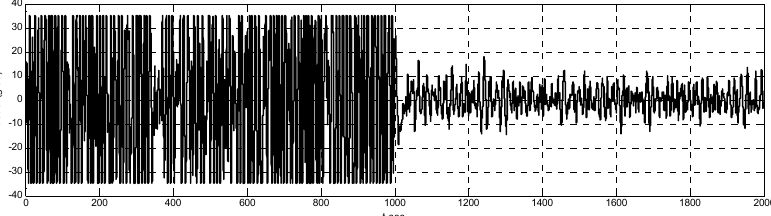
Figure 9. Graph of the function y ( t ) for the reference closed-loop connection in Regime 3 of motion.